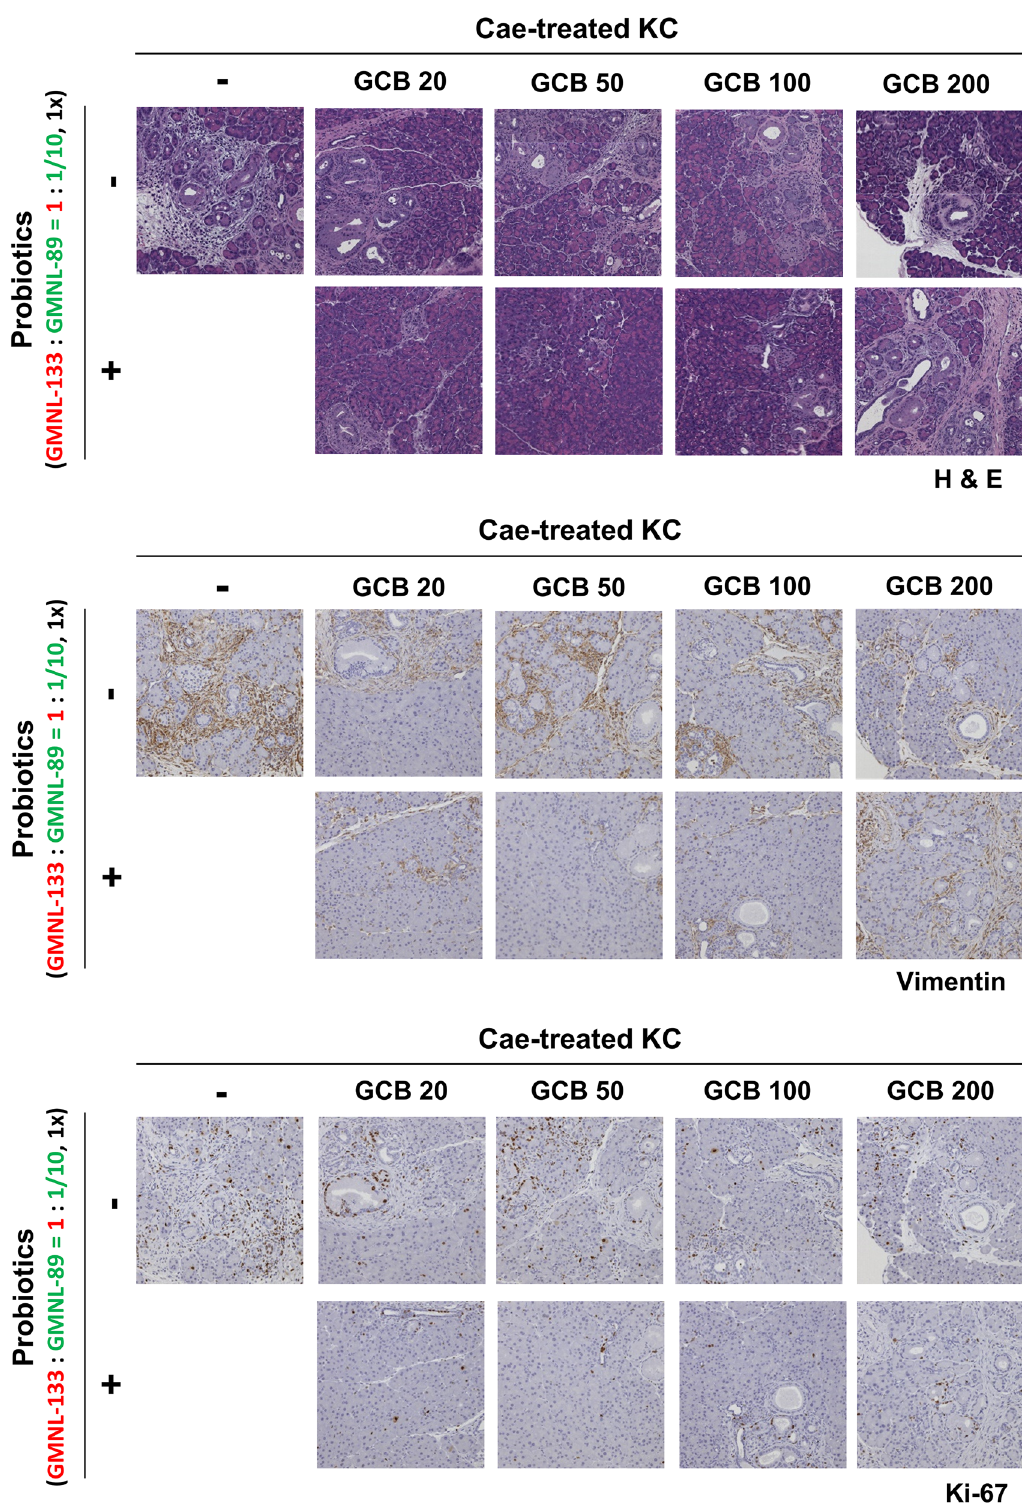
Figure 3. Representative images of pancreatic sections after various doses of gemcitabine in caerulein-treated KC transgenic mice with the co-administration of probiotics (GMNL133: GMNL89 in 1:1/10 ratio). The dosage of gemcitabine was 20 mg/kg (n = 3), 50 mg/kg (n = 3), 100 mg/kg (n = 3), and 200 mg/kg (n = 4). The combined application of gemcitabine and probiotics resulted in a lower grading of PanIN lesions by H&E staining and lower expression of vimentin and Ki-67. Cae, caerulein; GCB, gemcitabine; H&E, Hematoxylin and eosin; KC, LSL-Kras G12D/- ; PDX-1-Cre transgenic mice; PanIN, pancreatic intraepithelial